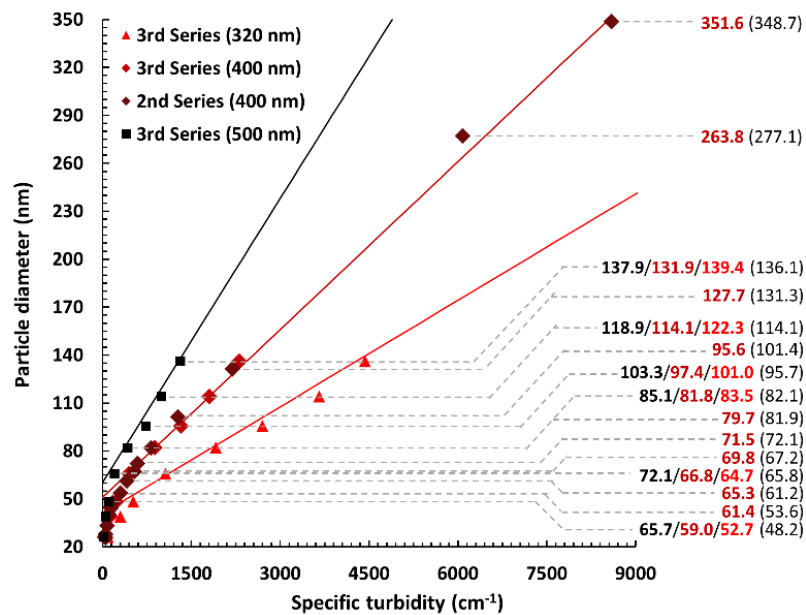
Figure 6. The linear approximation models (for three wavelengths of visual light) for the calculation of the mean particle diameter of Stöber nanosilica samples obtained using the simplified methodology. Numbers on the right show values calculated using functions derived for 500 / 400 / 320 nm wavelengths and those obtained from TEM (in brackets). All approximations yield good results down to particle sizes of ~100 nm, those for 400 and 320 nm are applicable down to ~65 nm and even slightly below 50 nm the 320 nm model still returns tolerable (error < 10%, < 1 SD) values, in accordance with previous theoretical investigations.